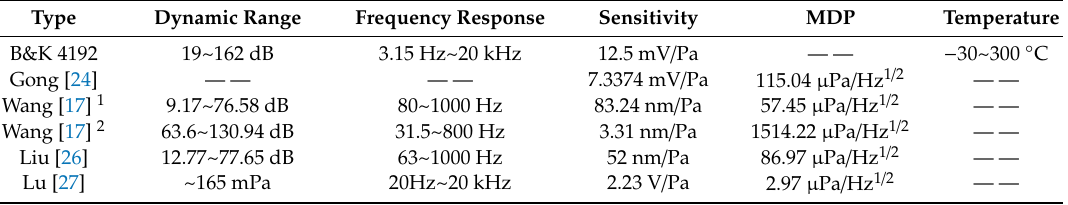
Table 2. Performance of CD-based acoustic sensors and commercially electronic acoustic sensor.